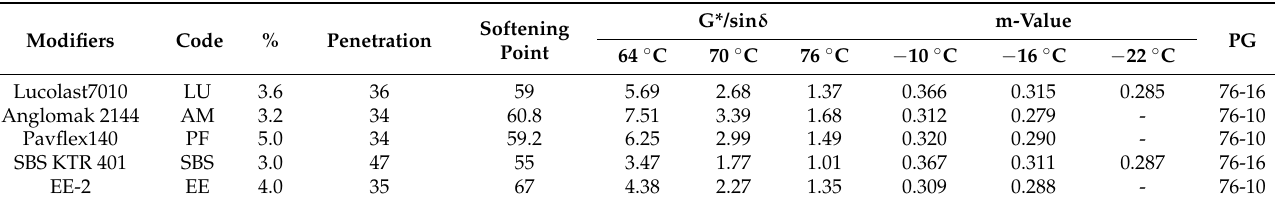
Table 5. The rheological and physical properties of